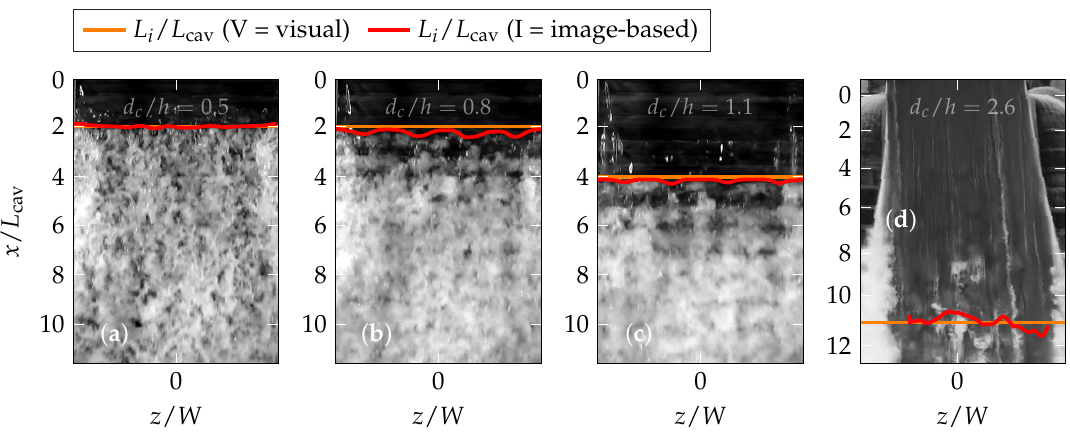
Figure 2. Inception point locations determined visually and via image-based analysis ( a – c ) instantaneous raw images (CASIO EX-10) of the laboratory flows for d c / h = 0.5, 0.8 and 1.1 ( d ) inception point location of the prototype spill with d c / h = 2.6.